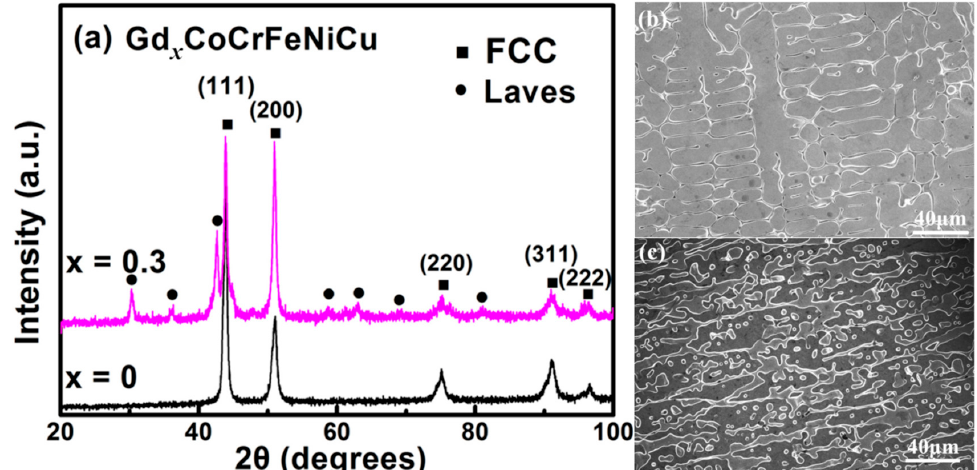
Figure 3. ( a ) XRD patterns of the Gd x CoCrFeNiCu; ( b ) Scanning electron microscope (SEM) microstructures of CoCrFeNiCu; ( c ) SEM microstructures of Gd 0.3 CoCrFeNiCu.